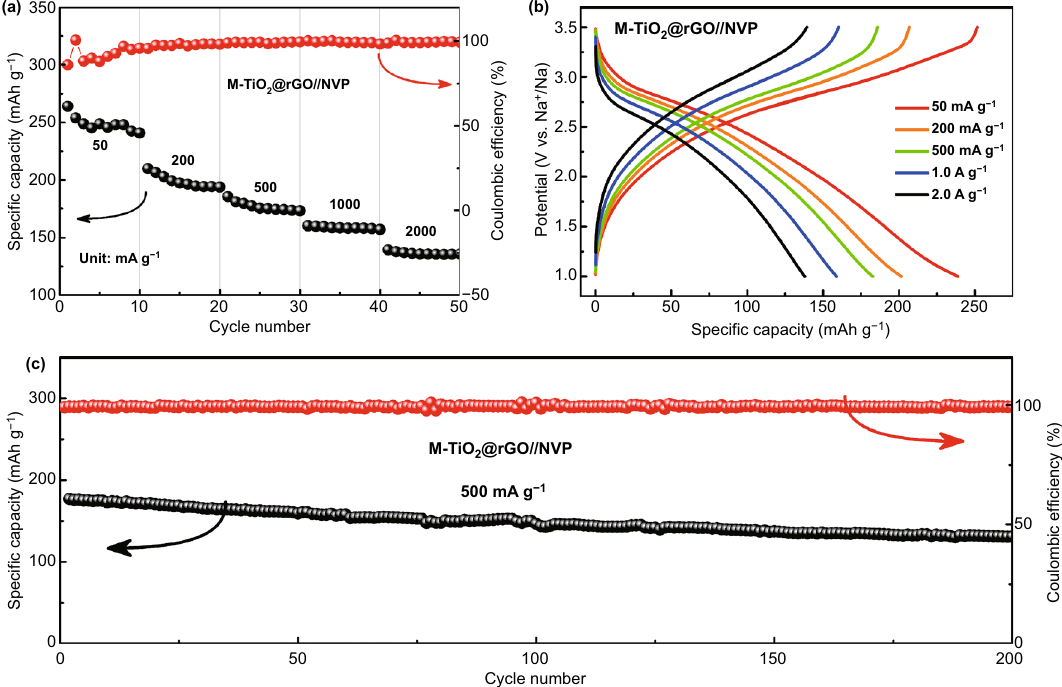
Fig. 6 Electrochemical performance of the sodium ion batteries (SIBs) with the NVP as cathodes and coated M‑TiO 2 @rGO as anodes. a Rate performance; b charge–discharge curves at different current densities; and c cycling performance at 500 mA∙g